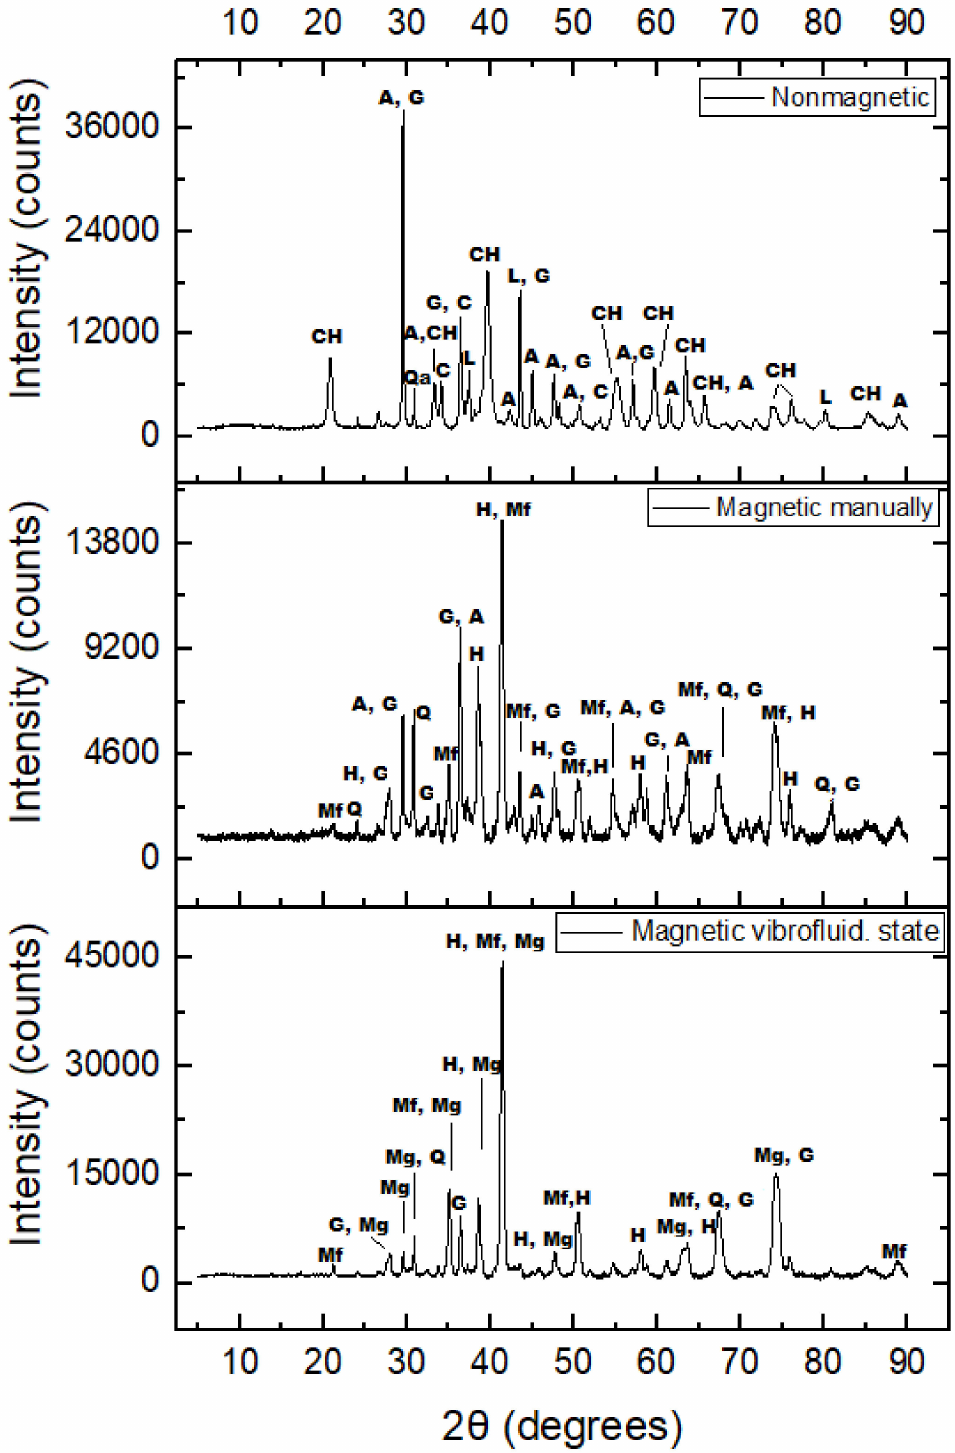
Figure 3. XRD patterns of the magnetic vibrofluid state, magnetic manual, and nonmagnetic fractions of the coarsest > 0.4 mm (A = Anhydride, B = Bilinite, C = Calcite, CH = Calcium Hydroxide, G = Gehlenite, H = Hematite, L = Lime, Mg = Maghemite, Mf = Magnesioferrite, Q = Quartz, Qa = Quartz alpha, R =